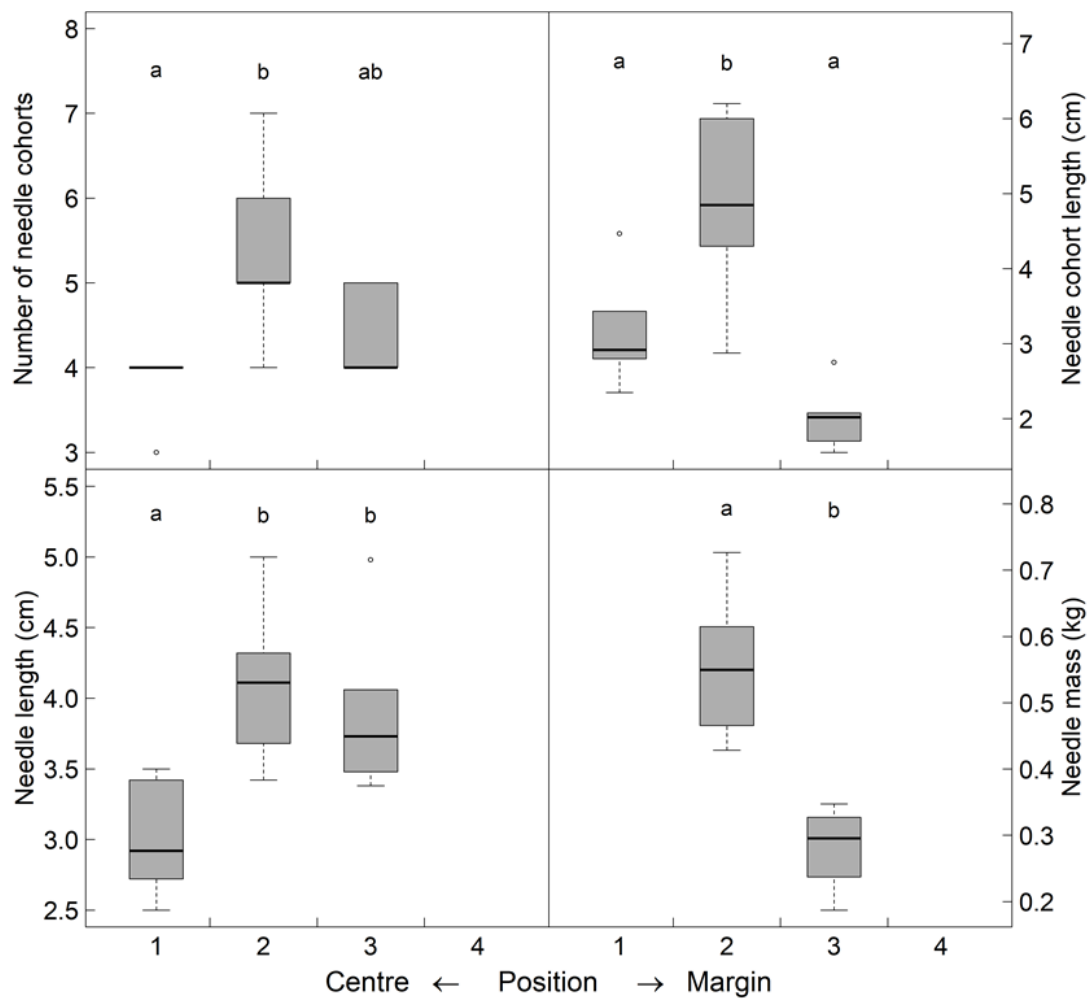
Figure 6. Number of needle cohorts, needle cohort length, needle length and total needle mass of small bog pines. Different letters indicate significant differences between the positions along the